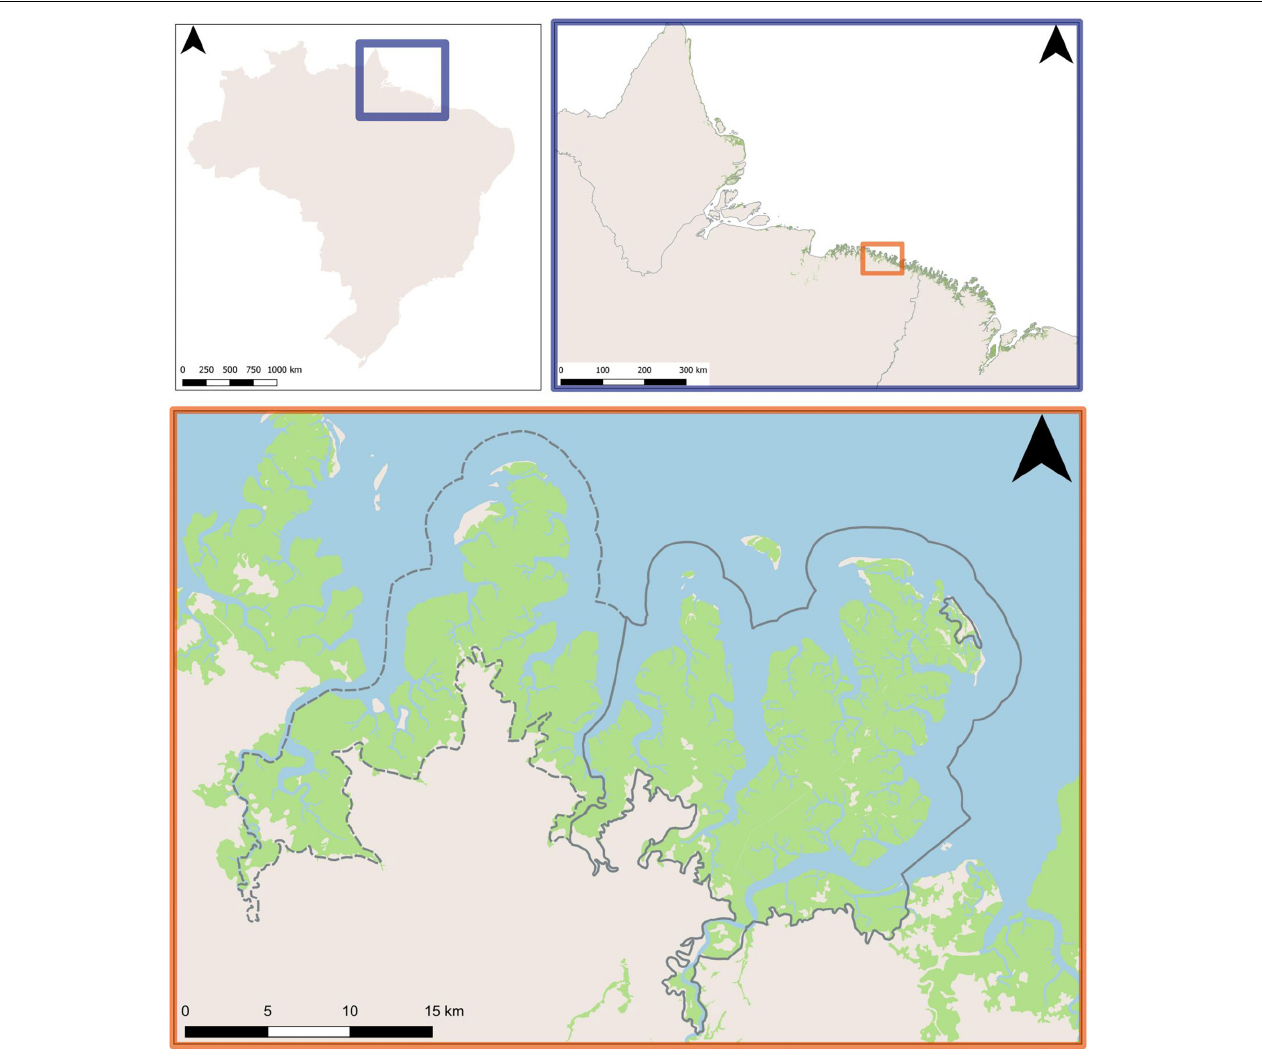
FIGURE 1 | Study area with the delimitations of the two protected areas, Tracuateua (west) and Bragança (east). Together they have 270 km 2 of mangrove area, which corresponds to approximately 40% of the total area of these two reserves.